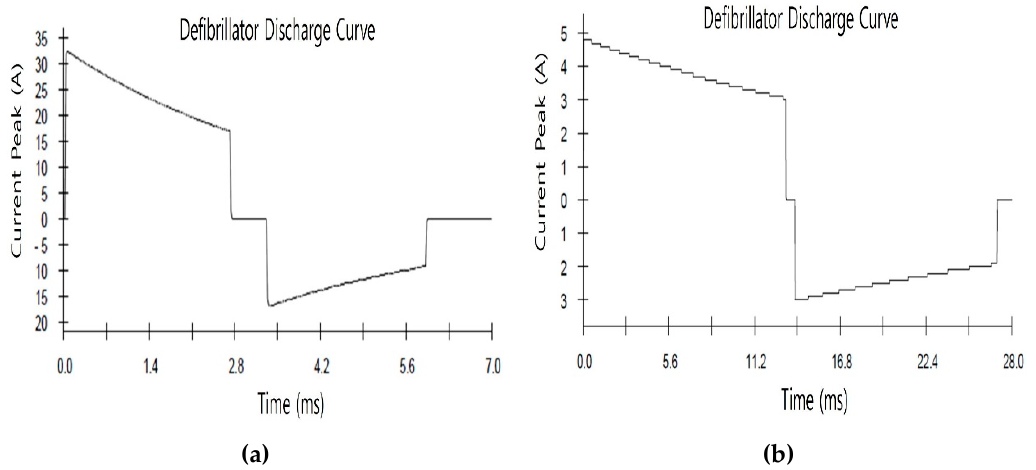
Figure 3. Adult mode of peak current: ( a ) 25 Ω Adult mode of peak current, ( b ) 175 Ω Adult mode of peak current.